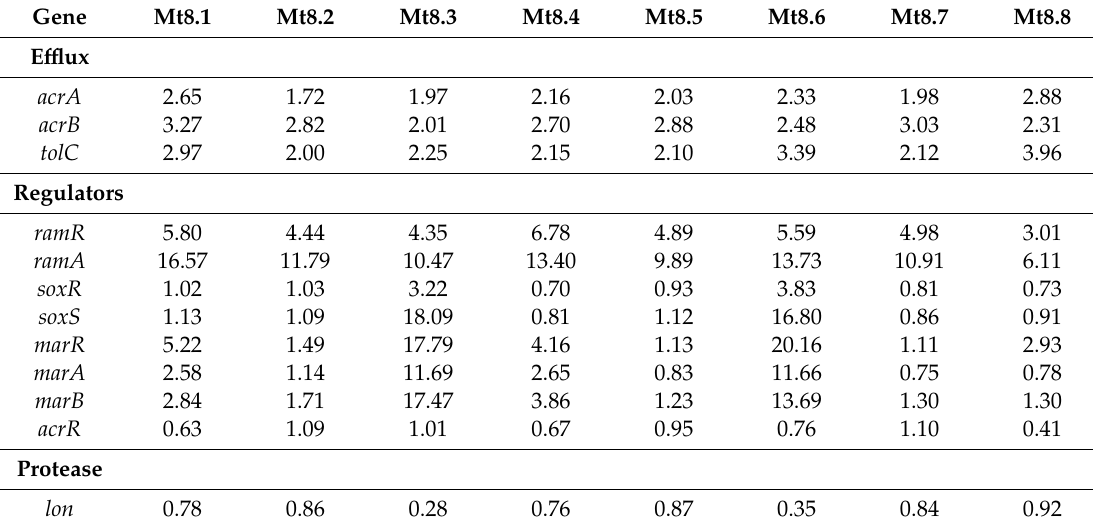
Table 4. RNA-Seq analysis of di ff erential gene expression in K. pneumoniae CHD-resistant mutants (Mt8.1–Mt8.8). Genes are grouped according to the annotated function (e ffl ux component, regulator or protease) of respective gene products, and values are given as fold-changes of expression levels (on the basis of reads per kilobase of transcript, per million mapped reads; RPKM) relative to the parent strain ( K. pneumoniae DSM-30104 wild